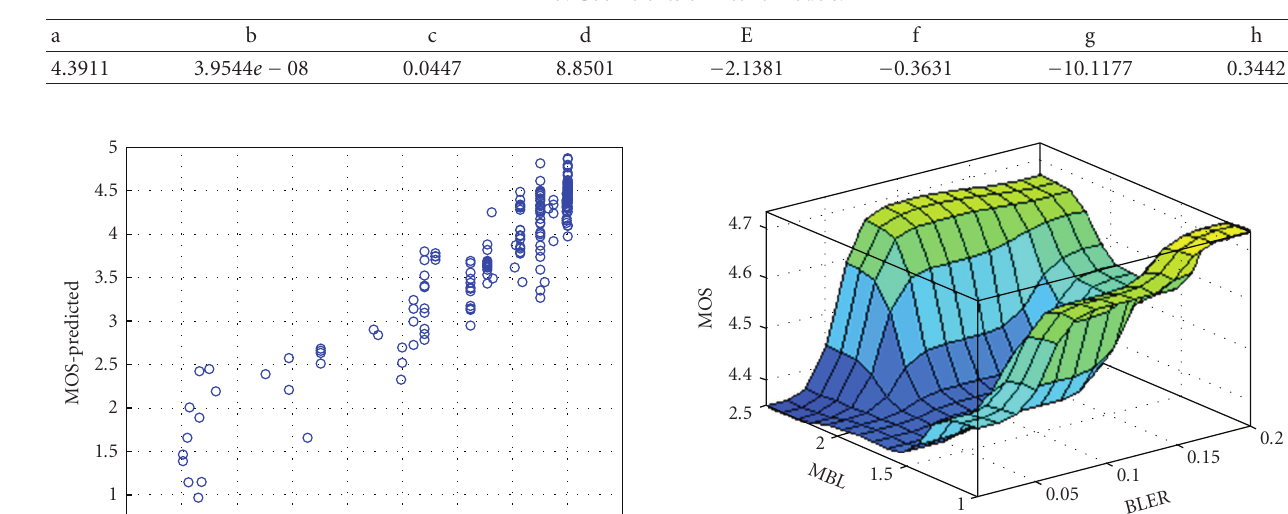
Figure 17: (a) Multiple comparison test for CT versus MOS. (b) Multiple comparison test for SBR versus MOS. Table 5: Coe ffi cients of metric models.